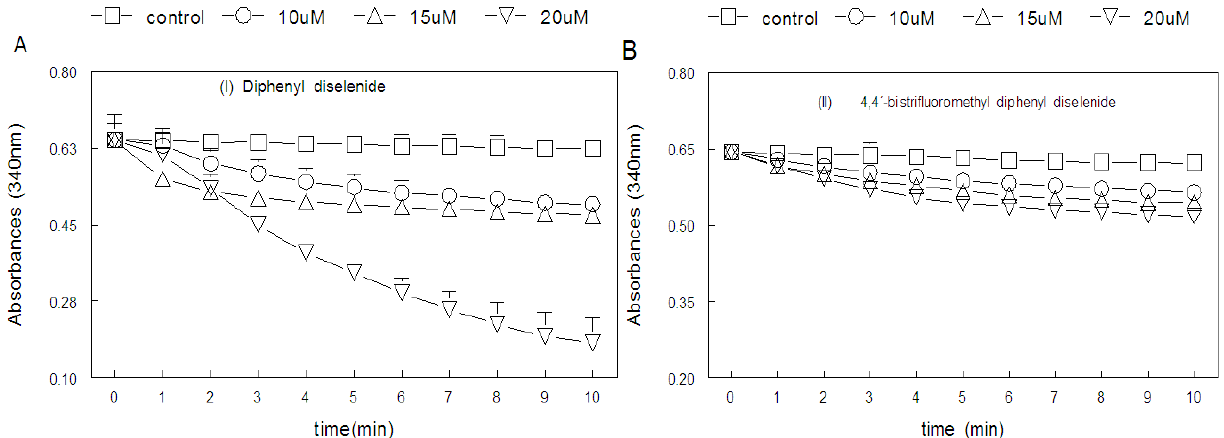
Figure 2. Reduction of diselenide compounds I (A), II ( B), III (C), IV (D), V (E) e VI (F) by NADPH catalyzed by mammalian Thioredoxin Reductase (TrxR). Enzyme was mixed with a medium containing 50 mM Tris-HCl, 1 mM EDTA, pH 7,5 and then reaction was started by adding NADPH (final concentration 100 µM). 0 ( □ ), 10( Ο ), 15( ∆ ), 20( ∇ ) µM diselenide compounds. Statistical analysis were performed by three-way ANOVA (six diselenides × four concentrations × 11 sampling points). Data analysis yielded a significant diselenide × concentration × time interaction F(150, 1,440) = 42.5; p < 0.000001, which indicates that the consumption of NADPH was dependent on the concentration, on the type of compound and on the sampling